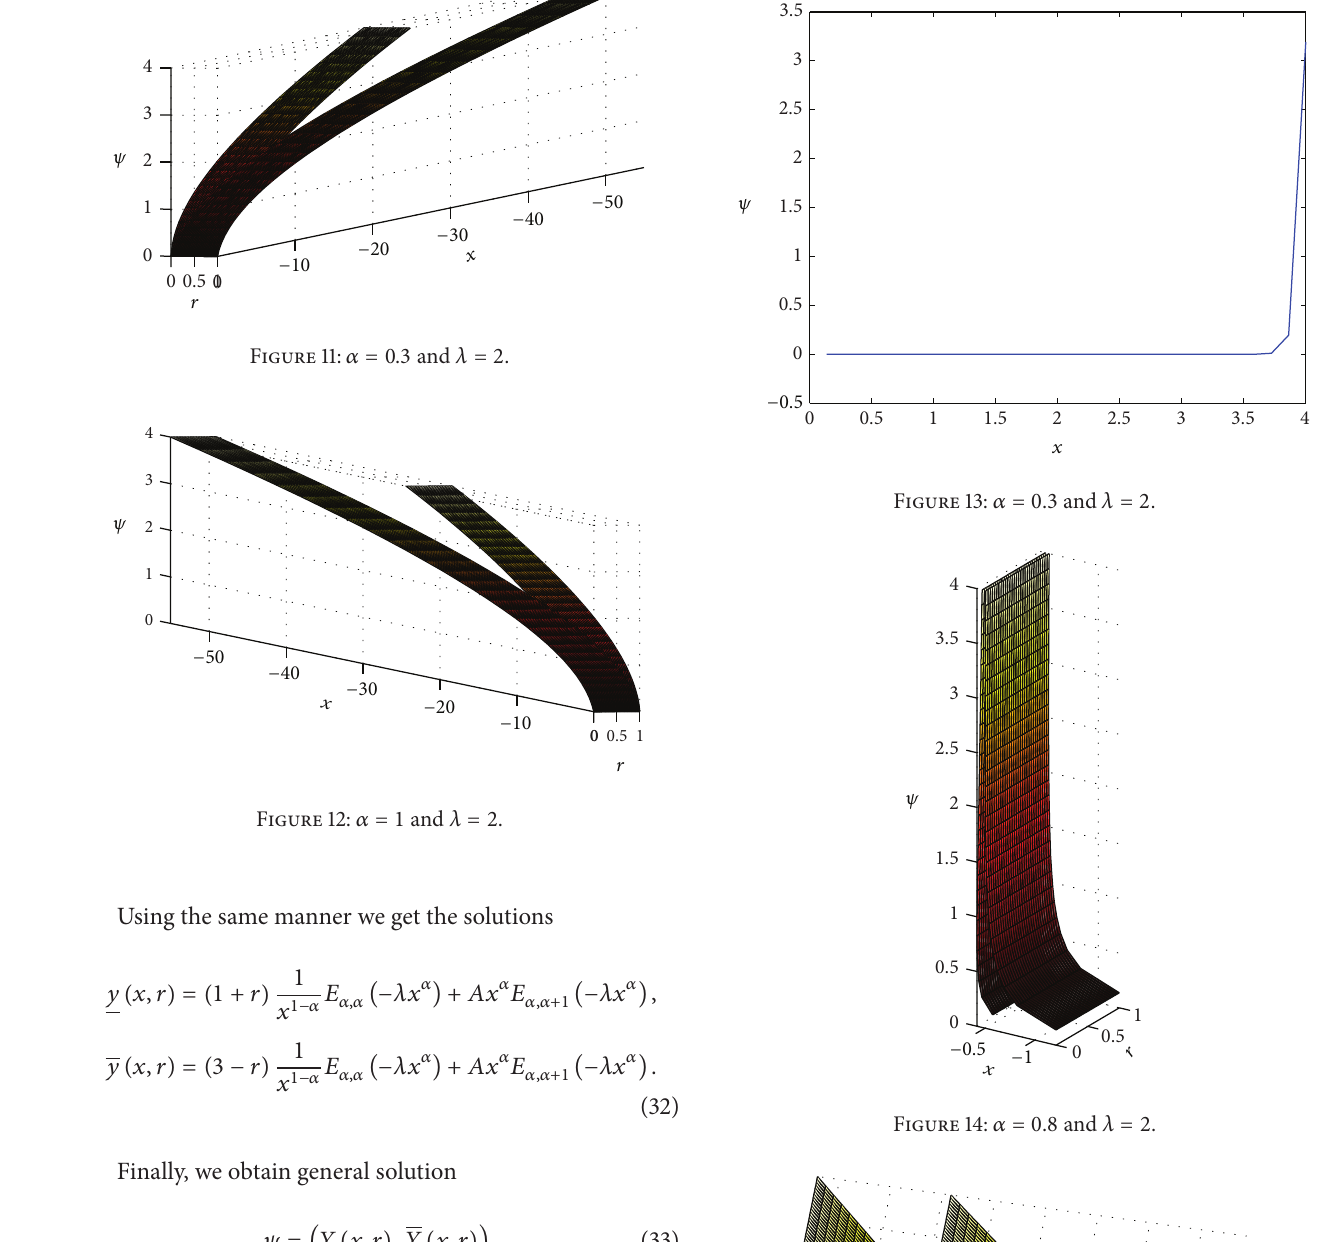
Figure 14: 𝛼 = 0.8 and 𝜆 = 2 .